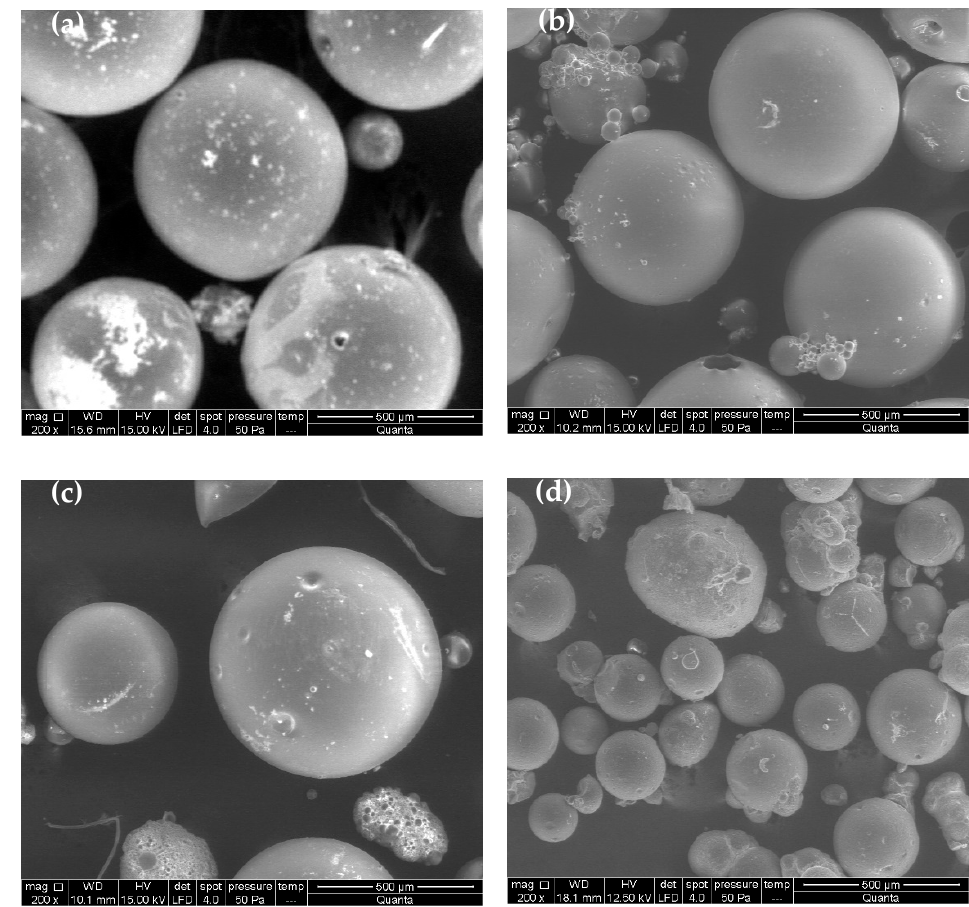
Figure 6. SEM micrographs of St-MMA particles ( a ), St-MMA-PEGMA particles ( b ), St-MMA-GMA particles ( c ) and St-MMA-GMA-PEGMA particles ( d ).